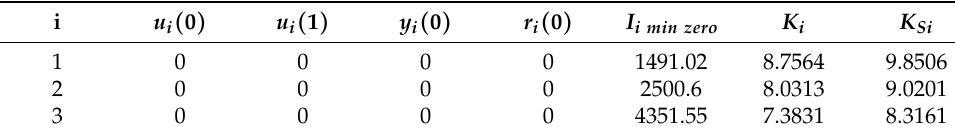
Figure 5. The constant damping coefficient curve with optimal values applied to it for nonzero and zero initial conditions. Table 3. Zero initial conditions and optimal